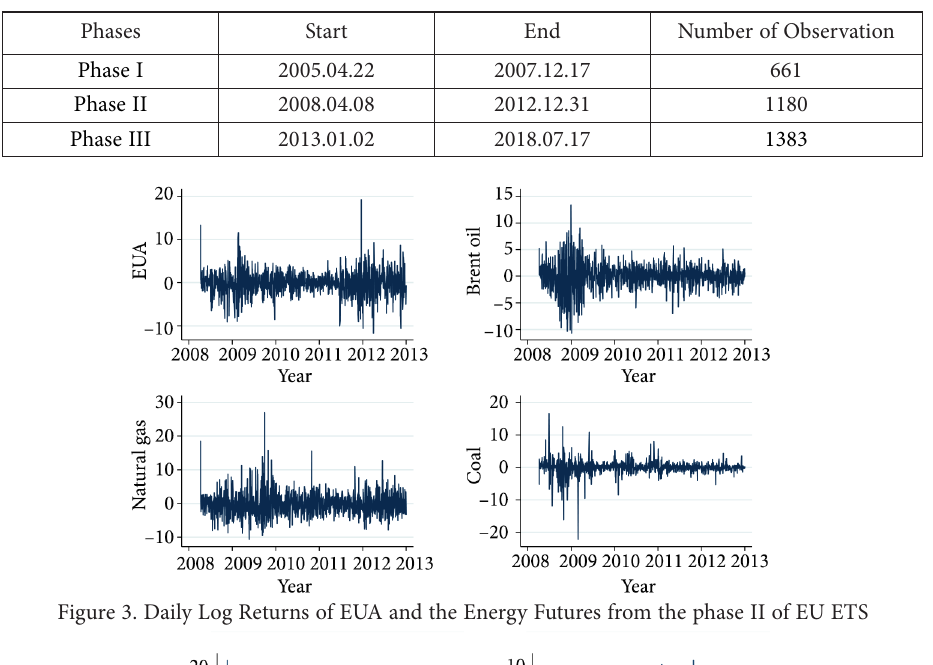
Table 1. Phase of EU ETS and the Number of